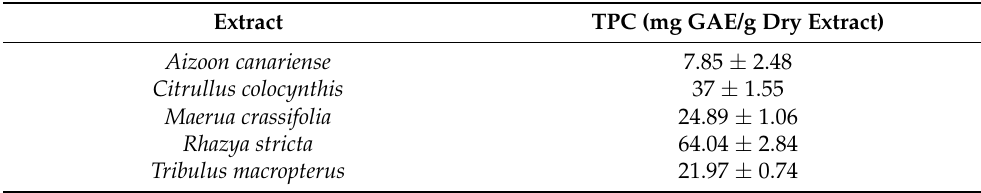
Table 3. Total phenolic content (TPC) of five plant extracts expressed as gallic acid equivalent per gram of dry powder extract (GAE/g) (mean ± S.D.). Results were obtained through three independent experiments, performed in triplicate.